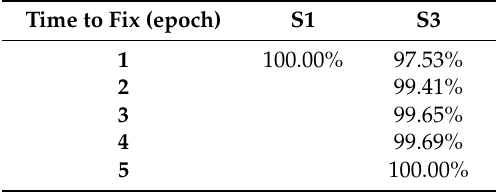
Table 2. Ambiguity-Fix Rate (AFR) of S1 and